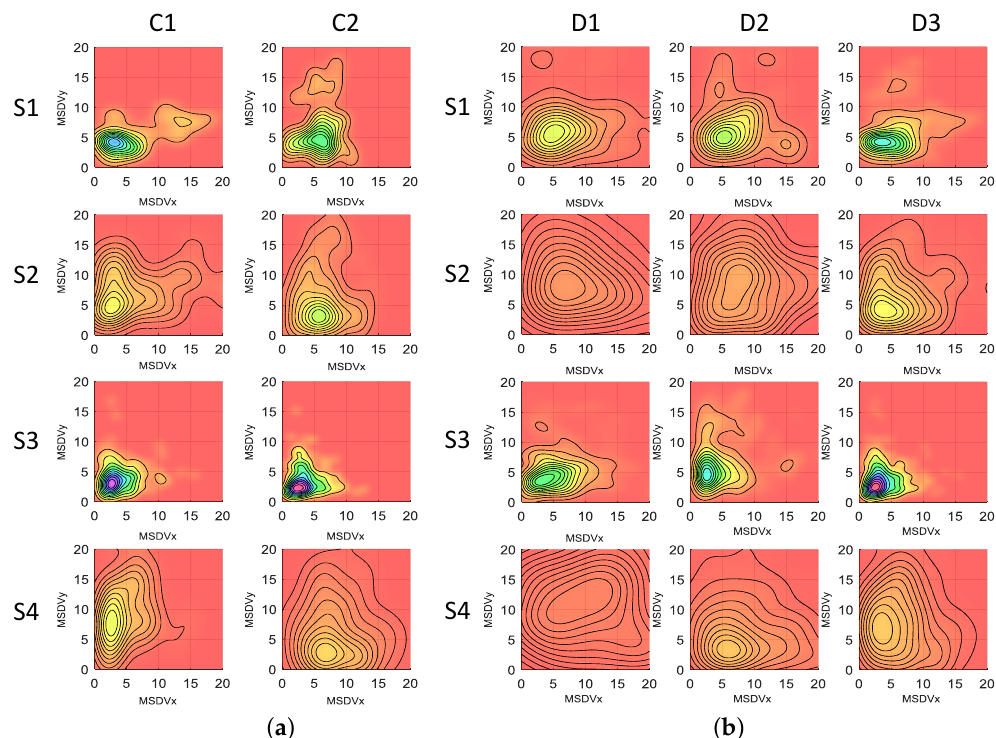
Figure 9. Bivariate kernel density function of the MSDV x and MSDV y for: ( a ) all sections (rows) and both vehicles (columns) when the driving style of D3 is considered; ( b ) all sections (rows) and all drivers (columns). The color represents the probability density, from red (improbable) to pink (probable) through yellow, green and blue. In addition, the closer the lines, the more regular the conduction